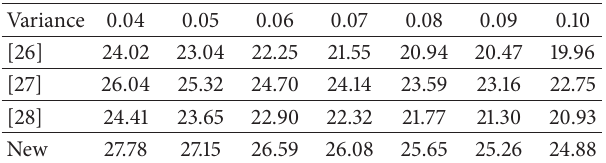
Table 2: PSNR of different algorithms with different Gaussian noise levels for Salesman video sequence.